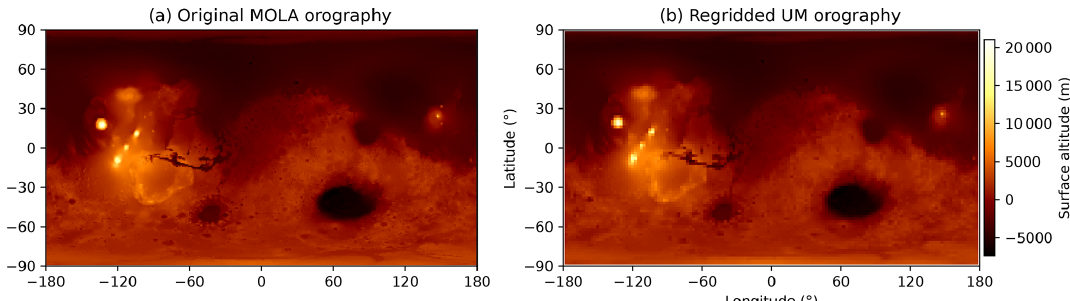
Figure 2. Original MOLA elevation data (a) compared to the regridded elevation data used in the UM (b) . Colour scales are matching between